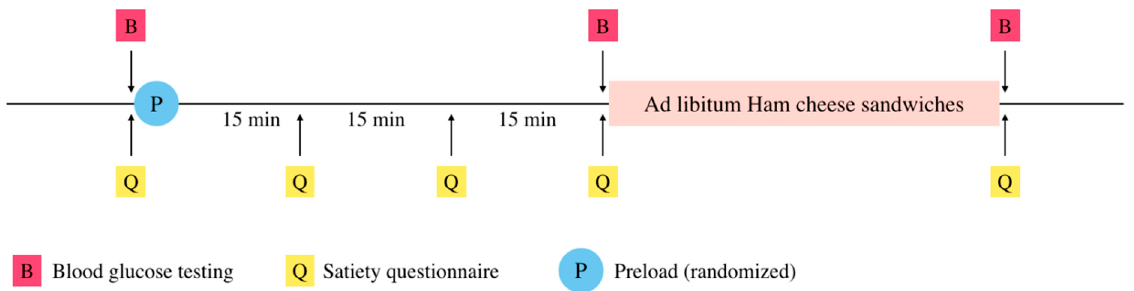
Figure 1. Schematic of study design on each test day.